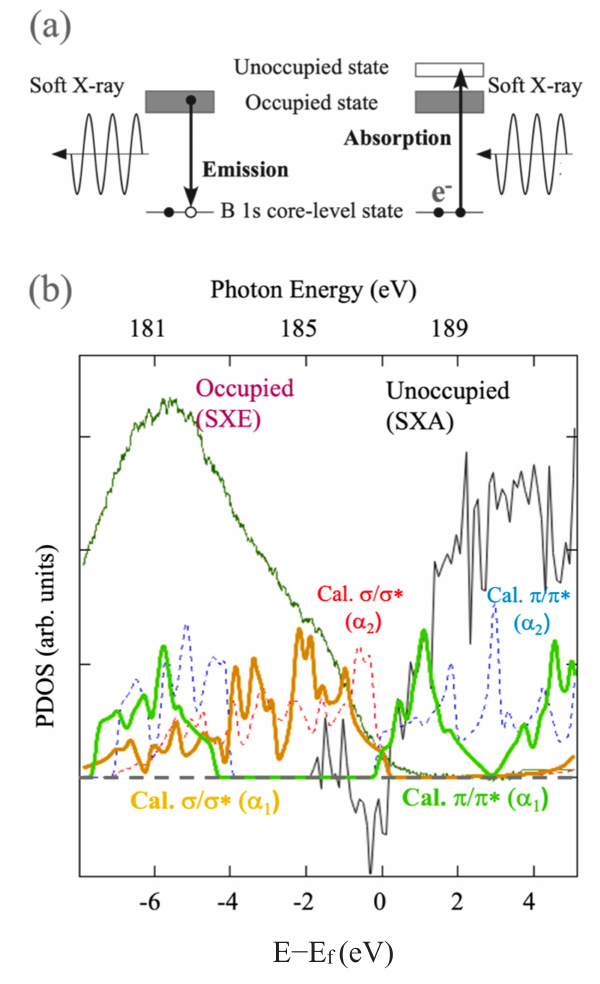
Figure 8. X-ray spectroscopy experiments on HB sheets. ( a ) Schematic picture of the soft X-ray emission and absorption (SXE and SXA) spectroscopy. ( b ) Spectroscopy data of the (5–7)- α HB sheet and calculated σ / σ ∗ and π / π ∗ bands for the (5–7)- α 1 and (5–7)- α 2 HB sheets (adapted from